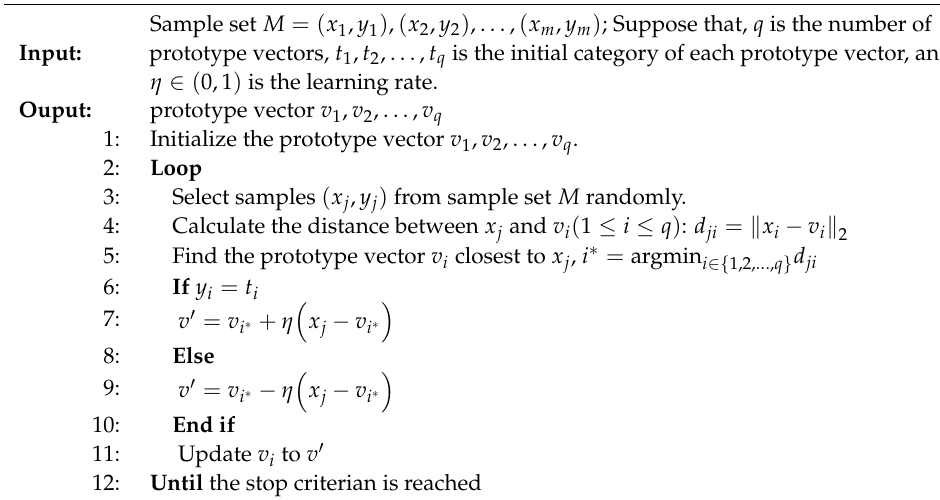
Algorithm 1 Learning Vector